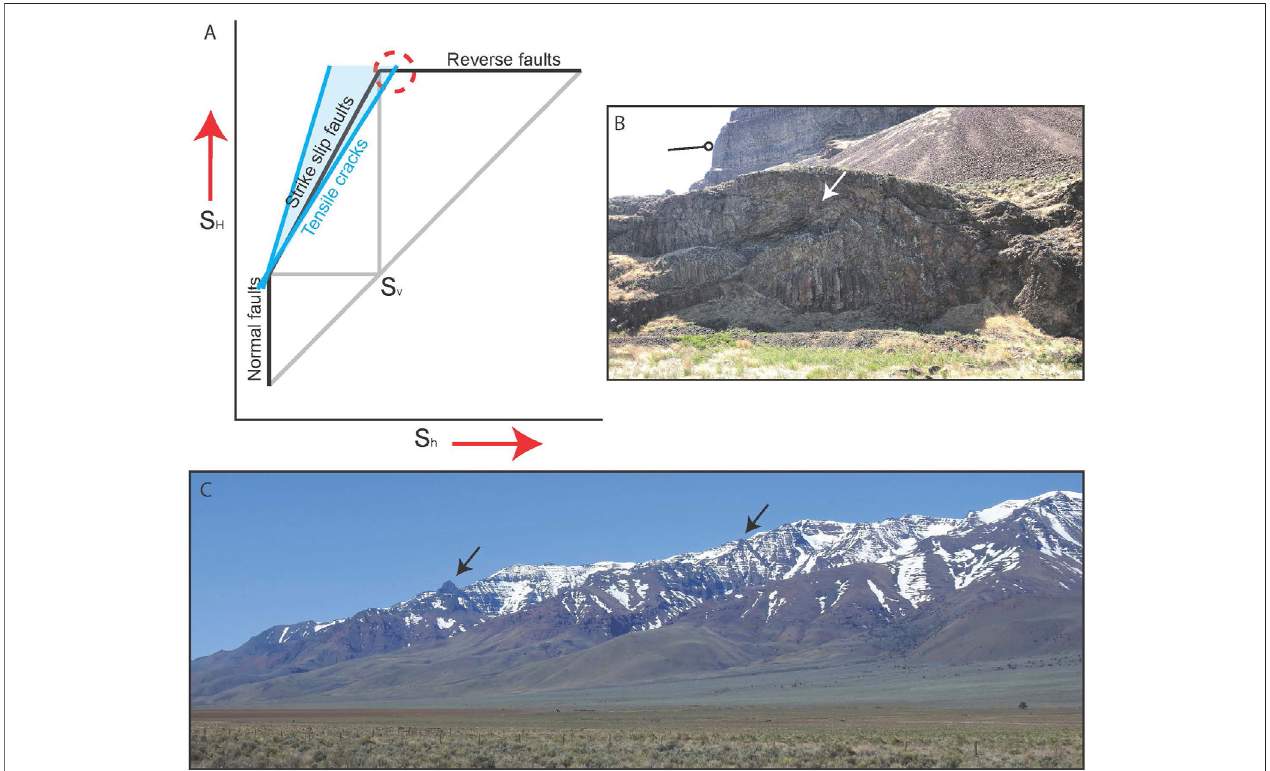
FIGURE 2 | A graphical representation of frictional faulting theory (adapted from Zoback, 2010) illustrates the stress relationships that must be satis fi ed when normal,strike-slip, orreverse faultsareobservedalongtheblacklines ofthepolygon (A) .ThecombinationsofS h andS H alongtheouter, blackedgesofthepolygon are de fi ned by the relationship between these values that must be observed when a Mohr circle de fi ned by these stresses and S v is tangential to a Mohr Coulomb failure envelope with a given coef fi cient of internal friction. Points along the lower vertical edge, sloping edge, and upper horizontal edge represent stress combinations that would produce normal, strike-slip, and reverse faulting, respectively, and points below these edges represent stresses not capable of producing faulting. The blue window conveys the relative S h and S H stresses that are expected when tensile cracks are observed or inferred either through borehole imaging or outcrop exposures. The steep edge of this window is de fi ned by the Grif fi th Criterion while the shallower edge is de fi ned by the Kirsch equations. Gray lines simply show the relationship betweenS v andotherstresses.TherepresentationsofequationsgoverningthestressrelationshipsbetweenS V andS H whenreversefaultsareobservedandS H andS h when tensile cracks are observed do intersect, and for this narrow window of stresses (red dashed circle), both dikes and thrust faults could propagate. (B) Evidence of suchsyn-volcanictectonismisobservedintheYakimafoldprovincewhere fl owsthinorshowonlapping(whitearrow)inthedirectionofdip(tadpole)forlargescalethrust fault-related landforms. (C) Large, vertical dikes observed near the surface are inferred to be feeder dikes. Here, we show an example of Steens dikes (black arrows) exposed at the surface and photographed during our fi eldwork in Fields,